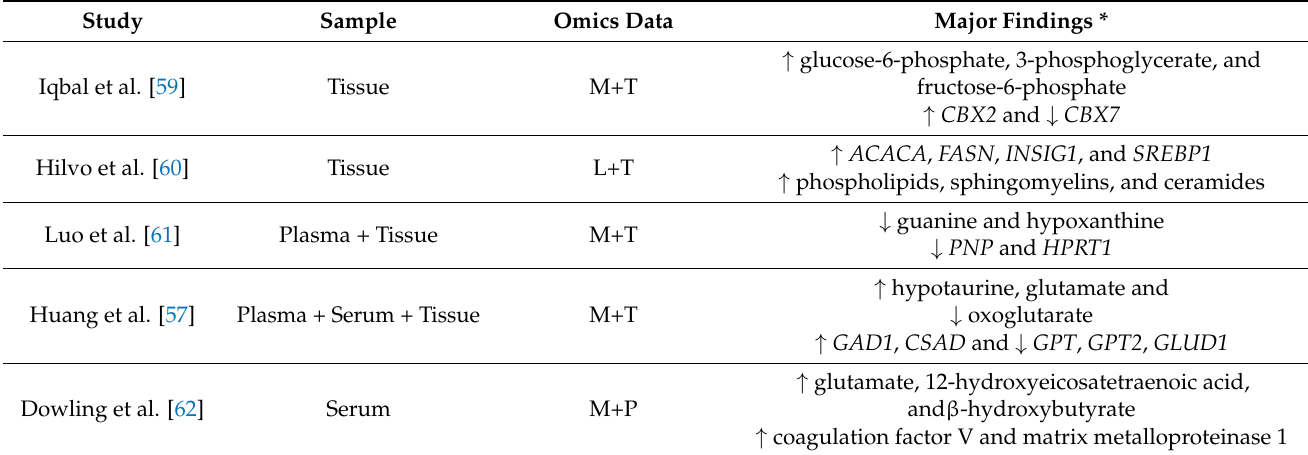
Table 1. Multi-omics studies focused on the identification of BC metabolic